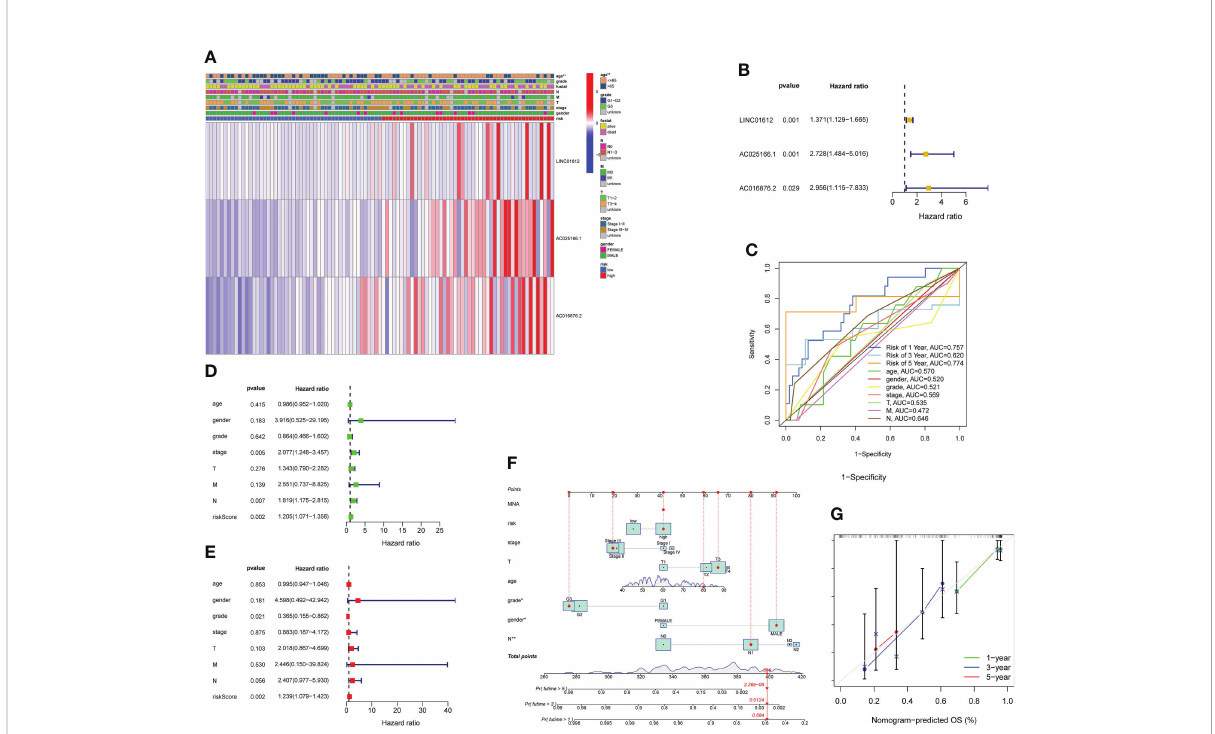
FIGURE 3 Evaluation of the value of prognostic risk model according to 3 m6A-related lncRNAs in EC patients in clinical practice. (A) Heatmap revealing the correlations between the levels of expression of 3 m6A-associated prognostic lncRNAs and clinicopathological characteristics, including age, sex, grade, TNM stage and AJCC stage, in the two subgroups. Signi fi cant differences in age were found between the two subgroups (p< 0.01). (B) As shown in the forest plot, we found that LINC01612, AC025166.1 and AC016876.2, HR values > 1, were risk factors in EC patients. (C) Multivariate ROC curves revealed that values of AUC for prognostic risk model of 1- and 5- year ROC curves were 0.757 and 0.774, re fl ecting their superior performance compared to conventional clinical features. (D) According to the results of a univariate Cox regression analysis, stage, RS, and N stage were all associated with prognosis. (E) Multivariate Cox regression analysis revealed that grade and RS were independent predictors of survival. (F) Nomogram, including both the prognostic signature and clinicopathological features, was designed to quantitatively estimate the prognoses of EC patients. (G) Nomogram calibration curve showing the coherence between predicted and observed OS for 1-, 3-, and 5-year periods. **p<